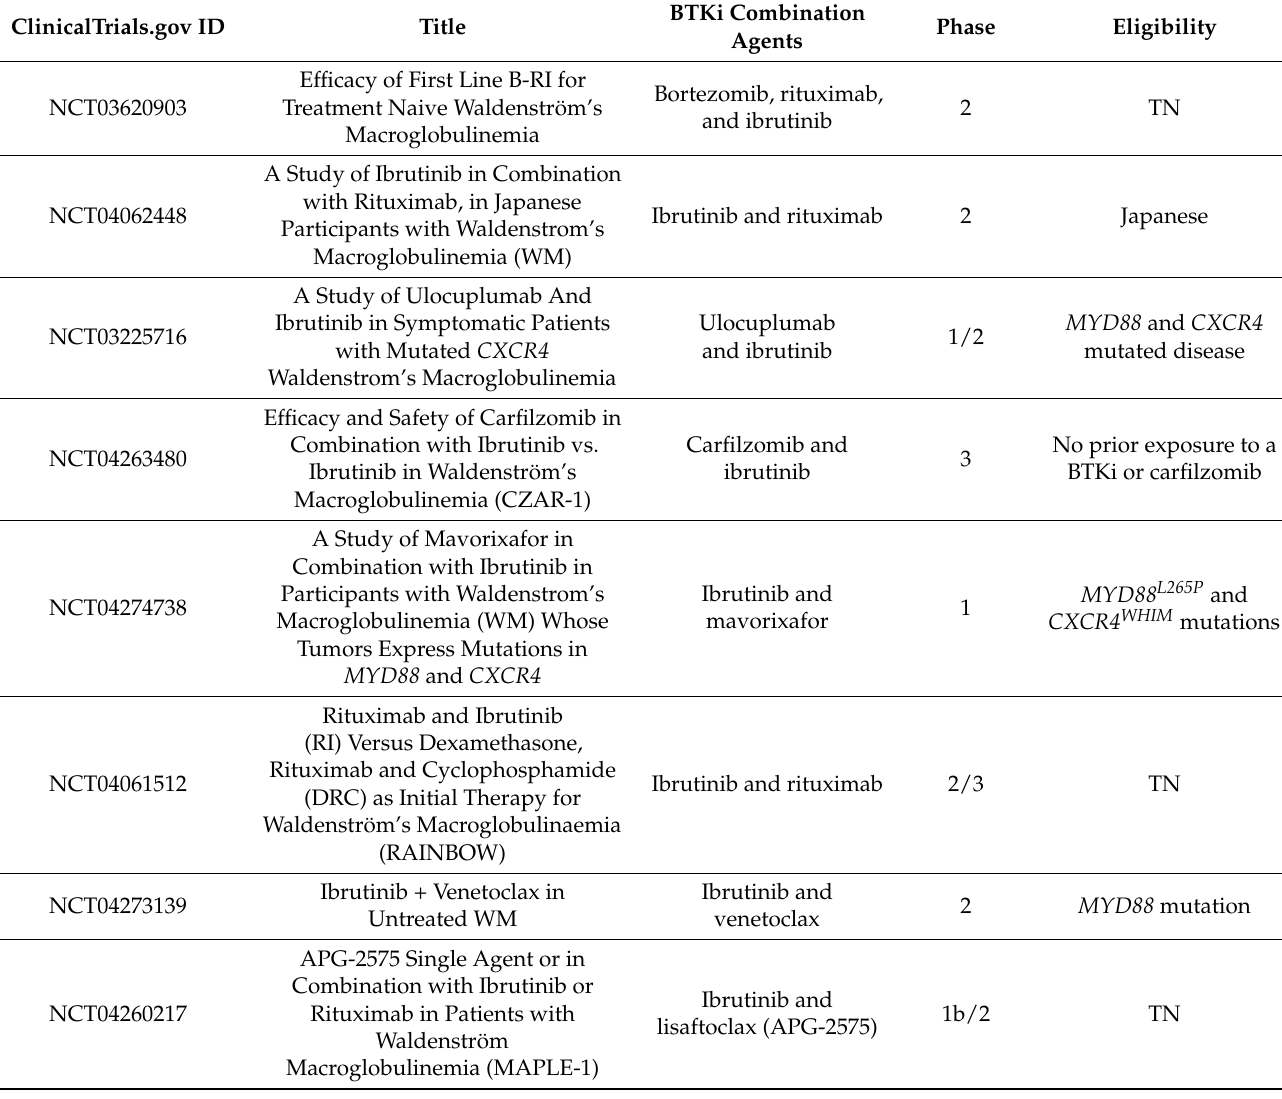
Table 2. Ongoing clinical trials using ibrutinib or acalabrutinib combination therapy in patients with Waldenström